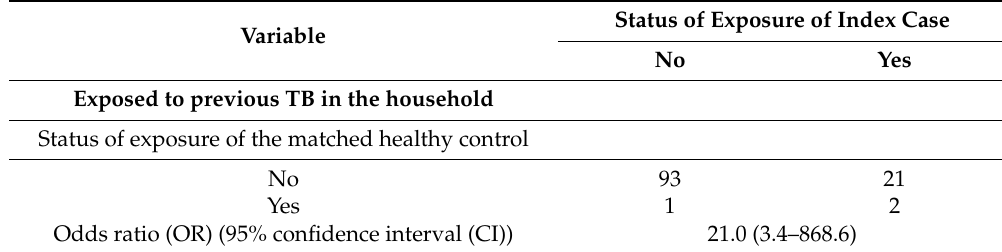
Table 2. Exposed to previous TB in household of index case and the matched healthy control (117 matched pairs).